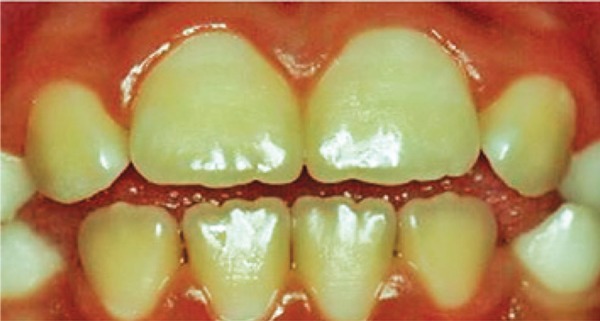
Dentes com fluorose muito leve